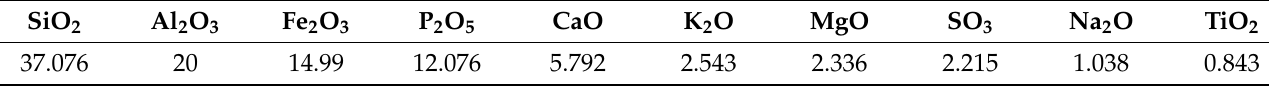
Table 2. Chemical composition of sewage sludge (wt.%).